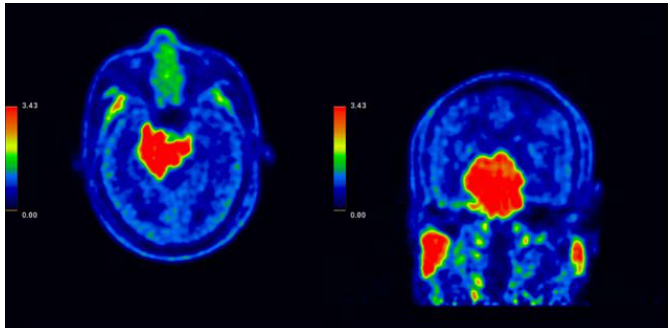
Figure 1. ( Left ) F-fluoro-phenylalanine-positron emission tomography (FBPA-PET) axial image of case 115, with the tumor-to-normal tissue standardized uptake value (SUV) average calculated after radioactive boron-containing drugs were infused into the patient. Other than the tumor, physiological uptake was also noticed in the parotid glands. The ratio of this patient is 2.89, matching the requirement of BNCT treatment (T/N ratio > 2.5) ( Right ) FBPA-PET coronal image.